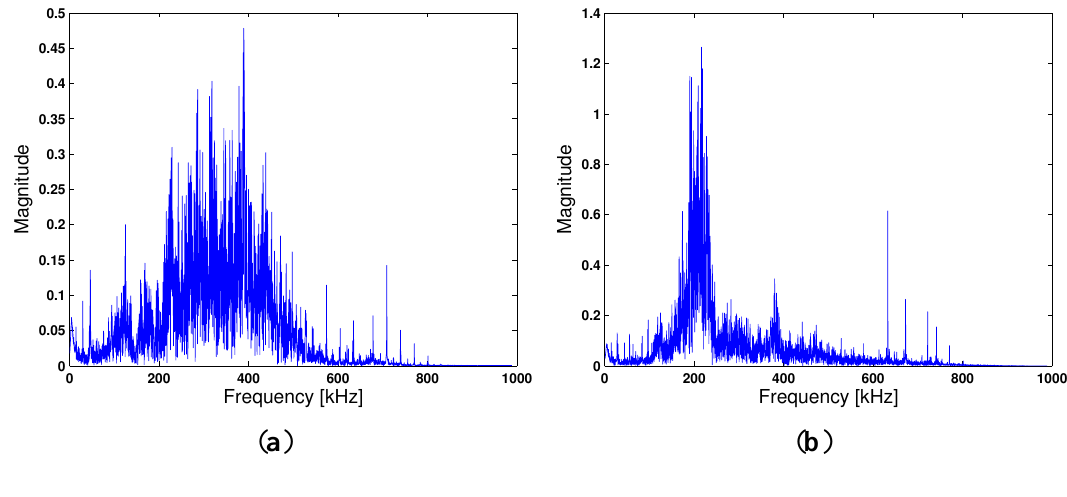
Figure 4. Frequency spectrum of channel responses that include PZT wafers. ( a ) Carbon steel pipe specimen; ( b ) stainless steel pipe